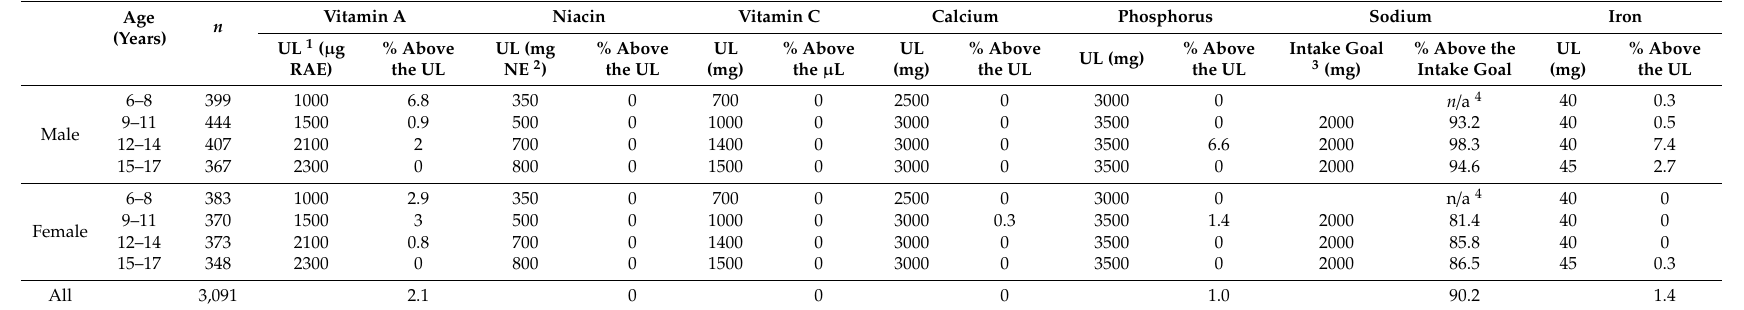
Table 5. The proportion of Korean school-aged children and adolescents with excessive nutrient